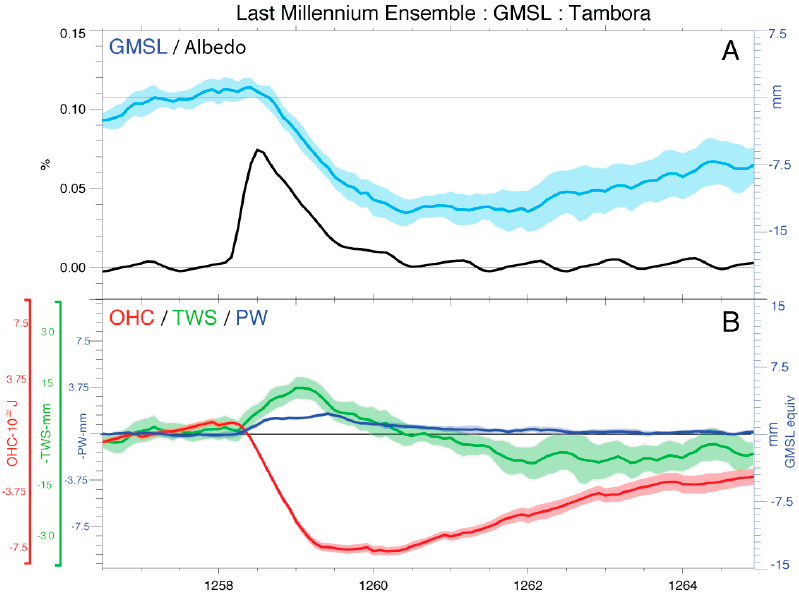
Figure 7. Anomalies in the LME associated with the April 1815 eruption of Mt. Tambora in: ( A ) clear-sky albedo over low latitude ocean (30 N–30 S) and GMSL; and ( B ) contributions from OHC, TWS, and PW. Shading indicates the σ range across ensemble members.